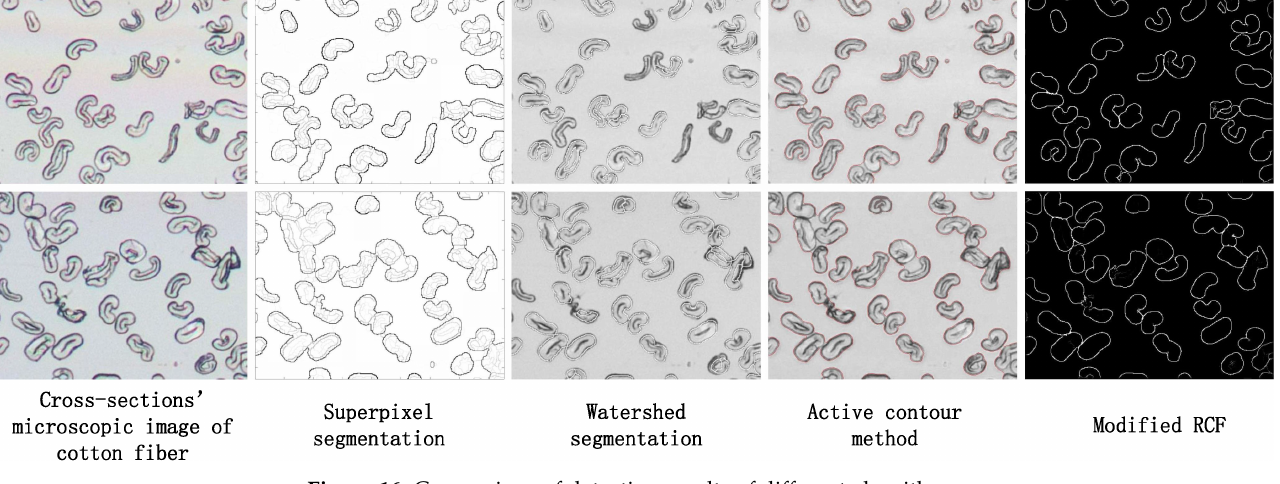
Figure 16. Comparison of detection results of different